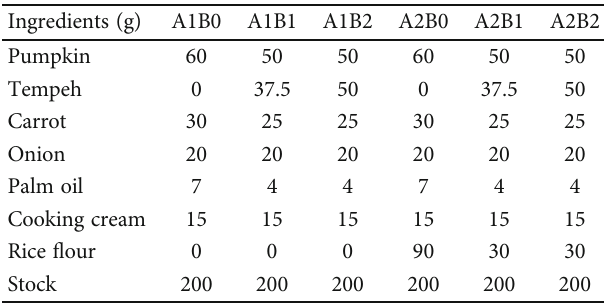
Table 1: Ingredient ’ s composition in pumpkin cream soup formula in one